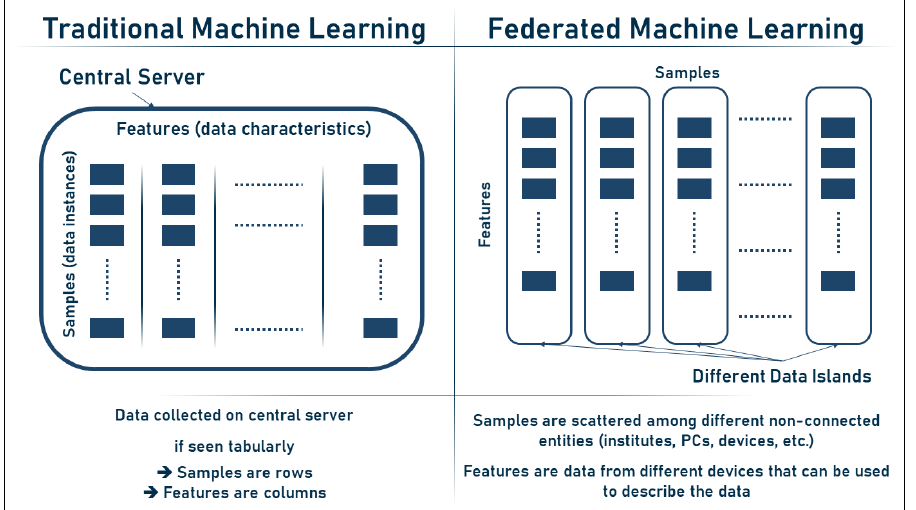
Figure 4. Samples vs. features in traditional and federated